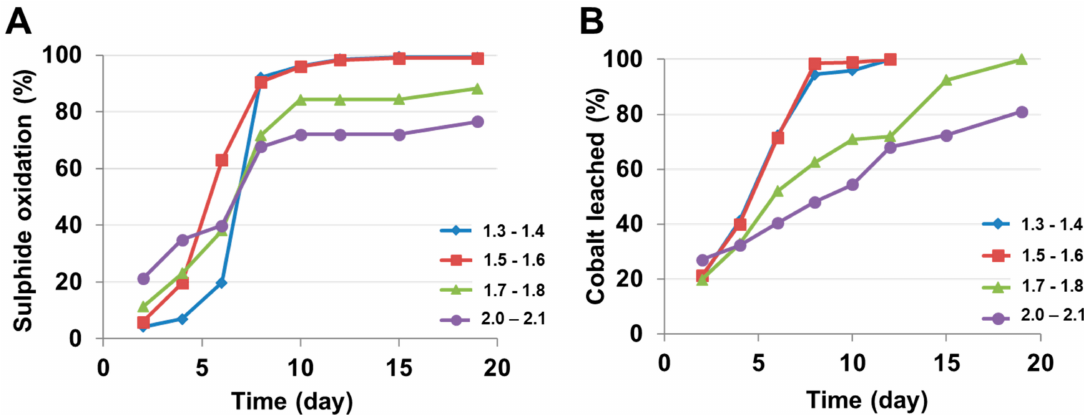
Figure 3. Calculated percentage of ( A ) sulphide oxidation and ( B ) cobalt in leachate for pH-modified